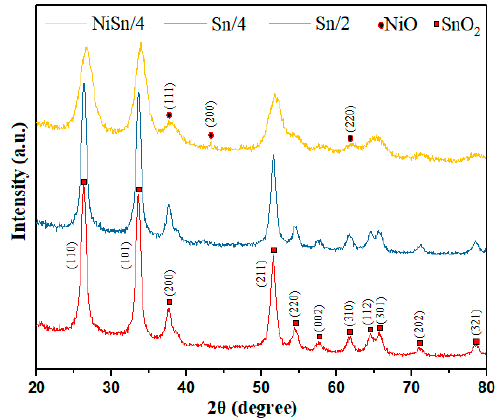
Figure 2. X-ray diffraction ( XRD) spectra of Sn/2, Sn/4 and NiSn/4 nanofibers.